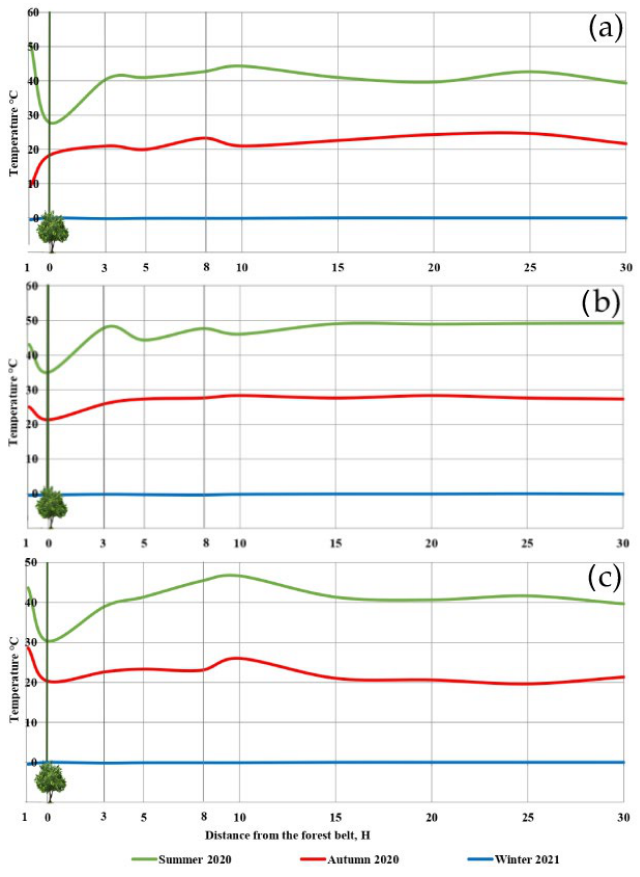
Figure 5. Soil temperature in ( a ) the morning, ( b ) the afternoon, and ( c ) the